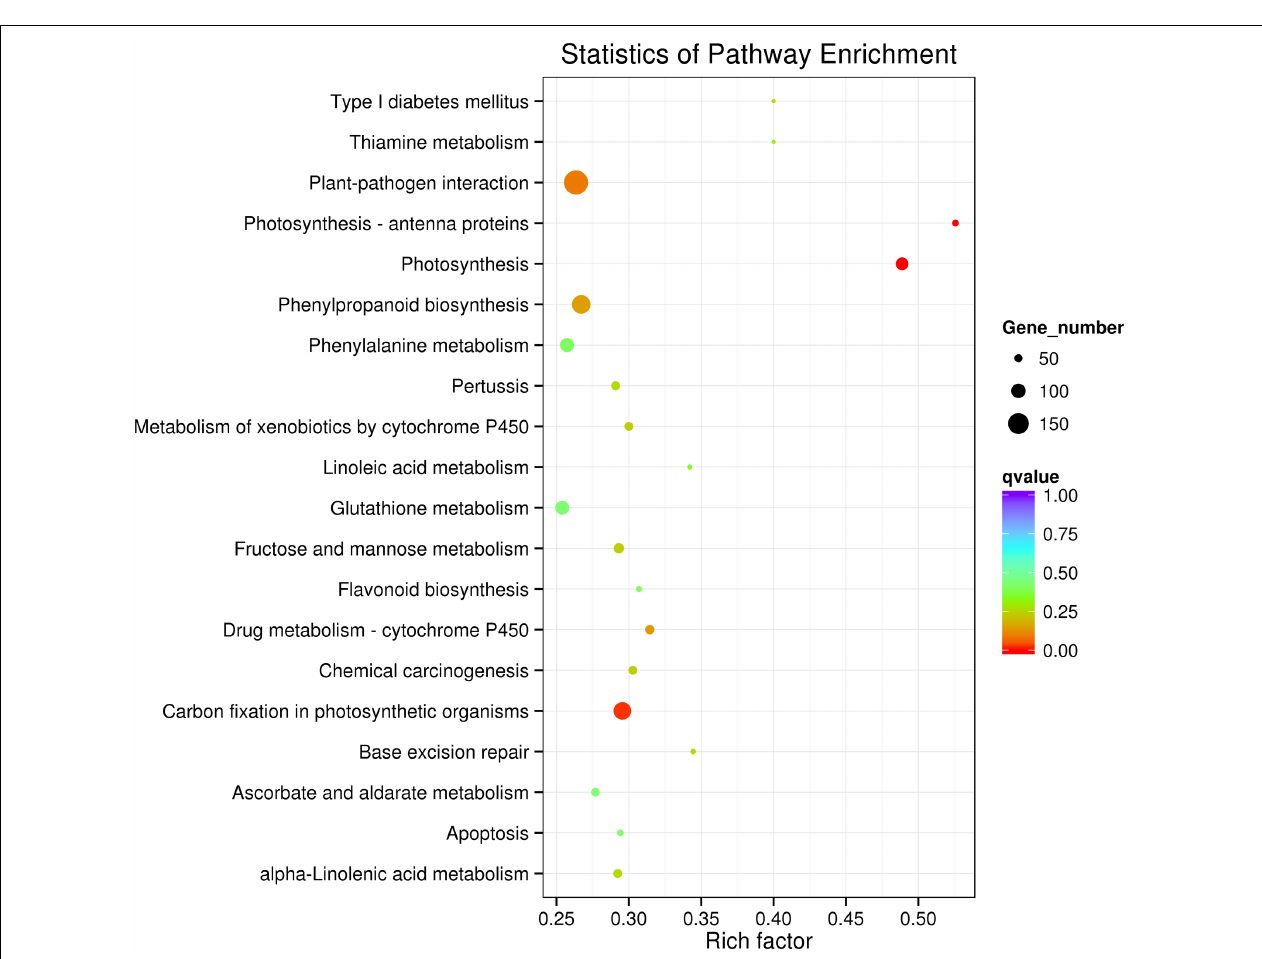
FIGURE 5 | Kyoto Encyclopedia of Genes and Genomes enrichments of the annotated DEGs between the control and heat stressed perennial ryegrass. The left Y -axis indicates the KEGG pathway. The X -axis indicates the Rich factor. A high q -value is represented by blue, and a low q -value is represented by red.